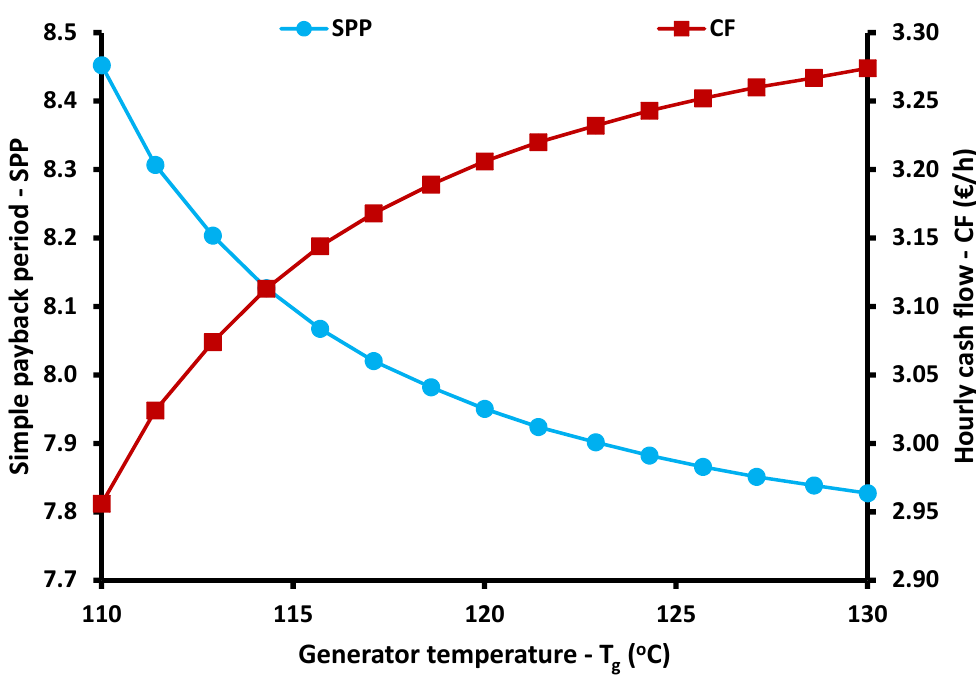
Figure 16. Simple payback period and hourly cash flow for different generator temperature levels.